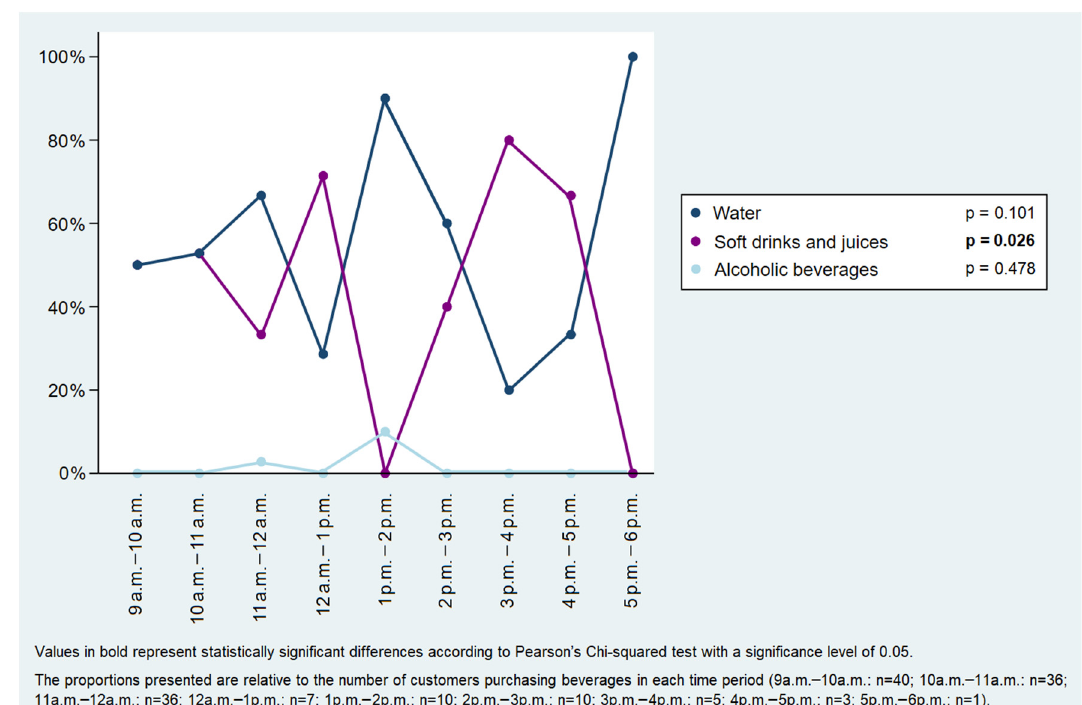
Figure 4. Distribution of the street food purchases throughout the day: ( a ) foods (n = 168) and ( b ) beverages. (n = 148).